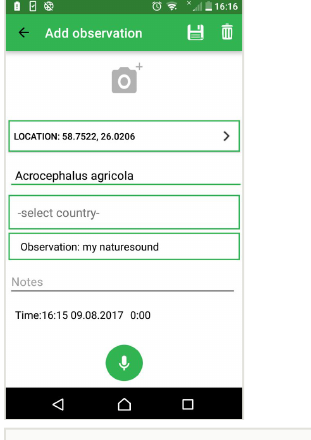
Figure 1. The application interface on the Android